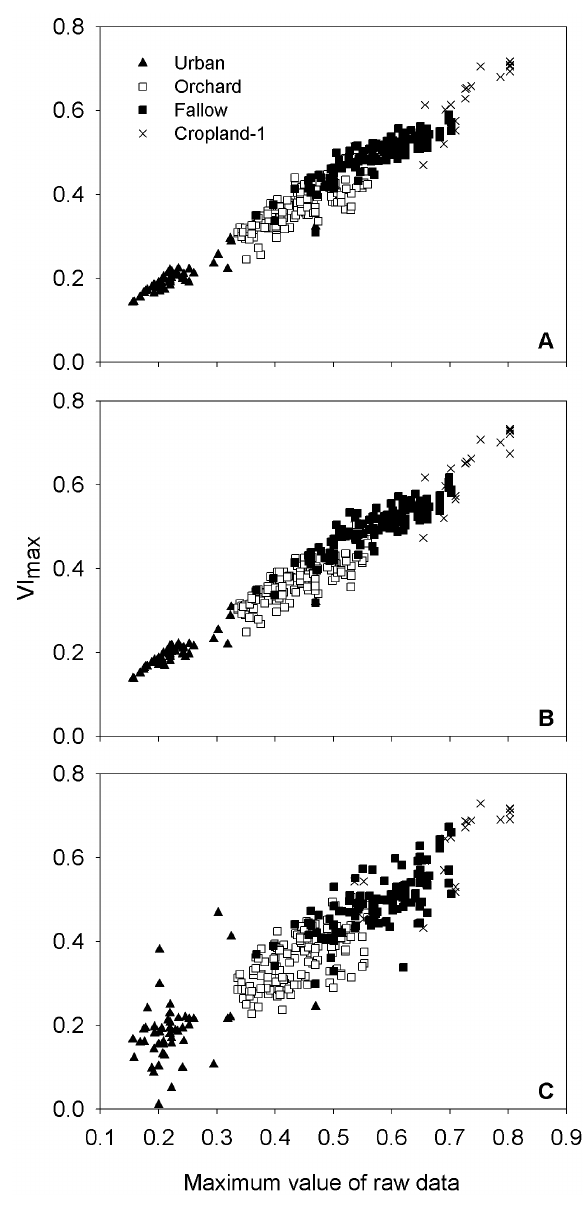
Figure 5. Results evaluation by comparing derived VI max with corresponding maximum values of raw data. Frames showed results that obtained with asymmetric Gaussian method (A) ( R 2 =0.944), double logistic function (B) ( R 2 =0.947), and Savitzky-Golay filter (C) ( R 2 =0.837) respectively.